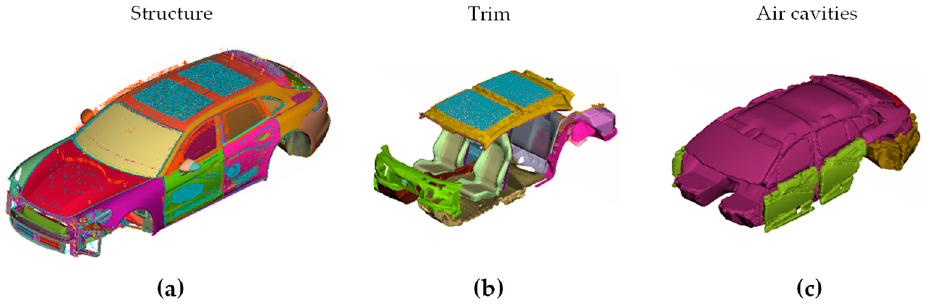
Figure 2. Trimmed body simulation model: ( a ) Structure model (FEM); ( b ) Trim (PEM); ( c ) Air cavities (FEM).